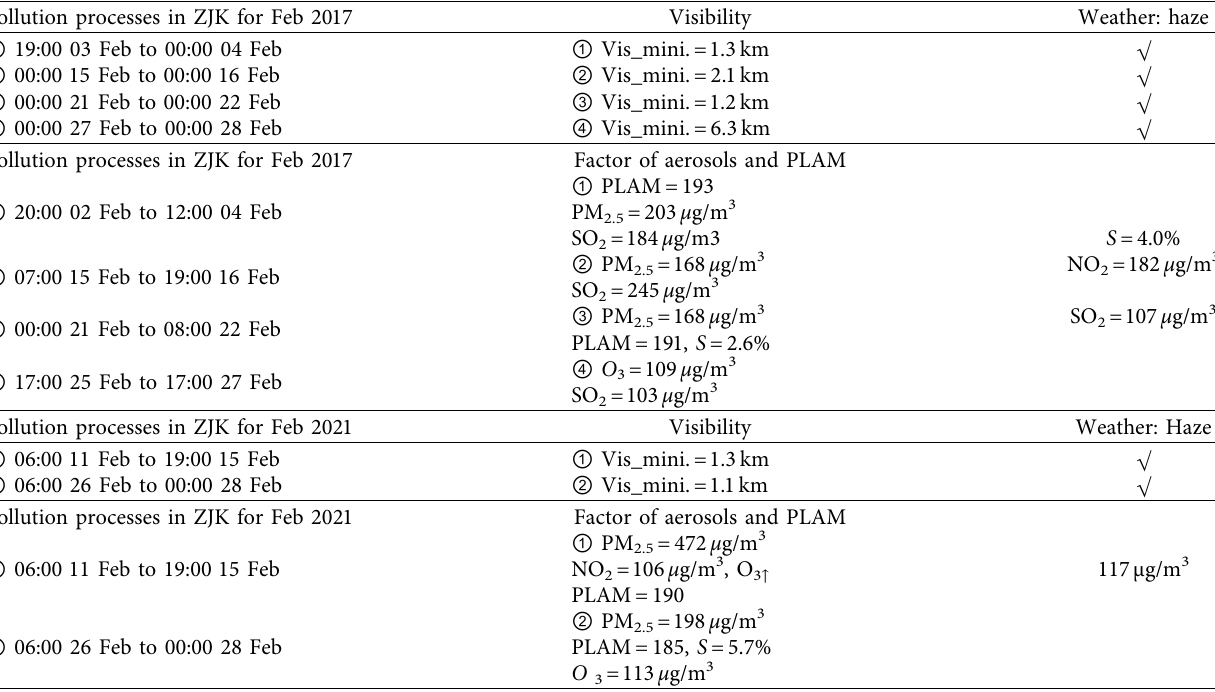
Table 4: Weather phenomena and atmospheric aerosol elements of the pollution process in Zhangjiakou for February 2017 and February 2021.